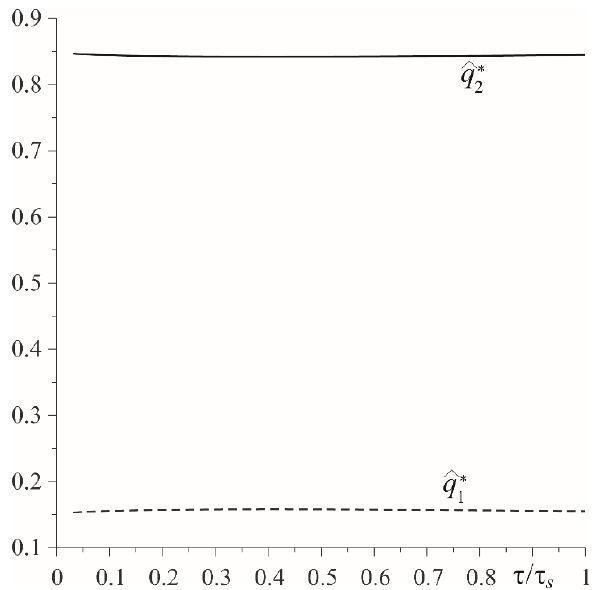
Figure 9. Evolutions of dimensionless intensities of heat fluxes 2,1,ˆ = ∗ lq normal from the friction surface to the insides of the elements made of cast iron (solid line) and FGM (dashed line) during braking with constant deceleration.